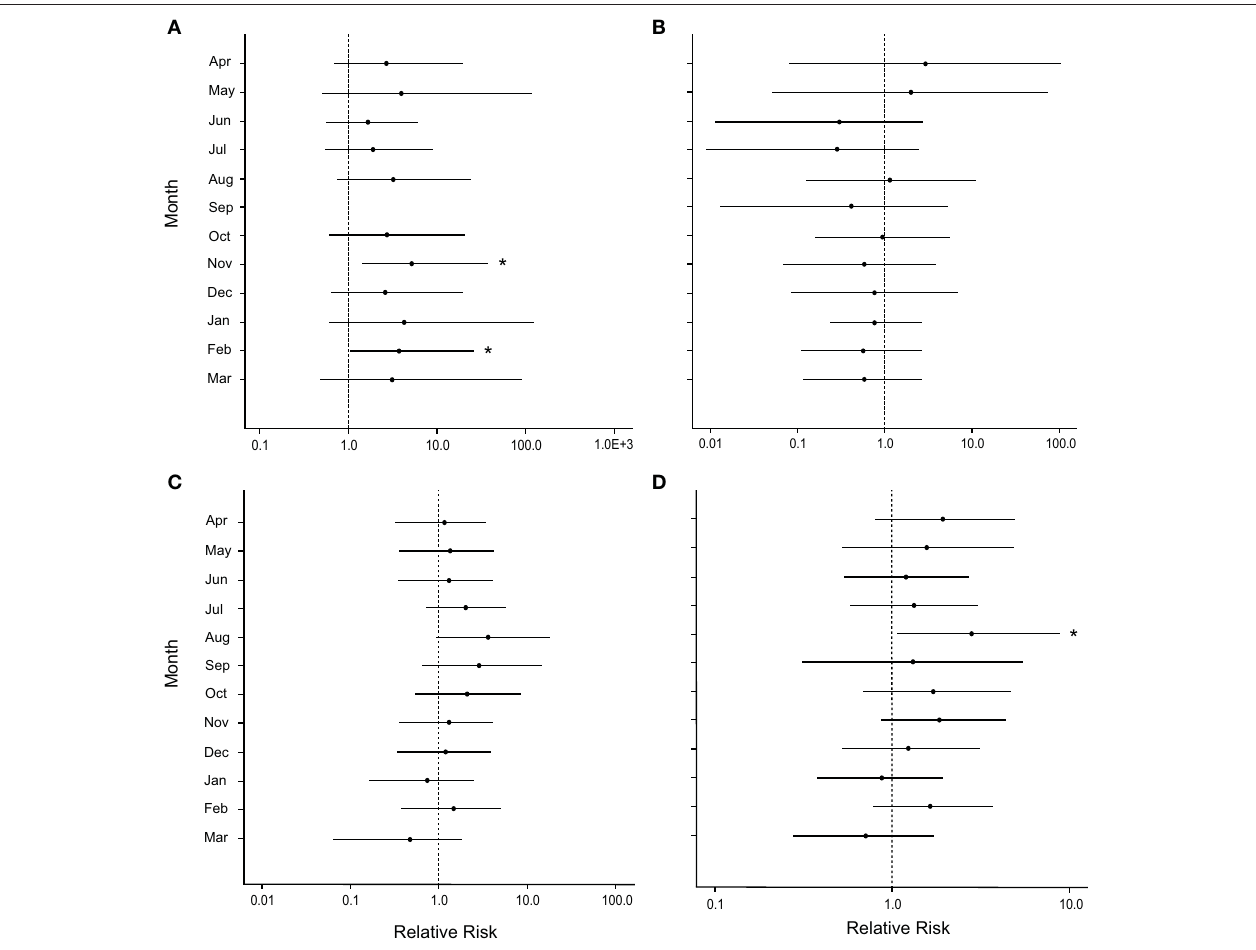
FIGURE 7 | Caterpillar plots depicting the median (black dot) and 95% credible intervals for the relative risk of occupation by the snail, Coralliophila abbreviata , after damage from the March swells at (A) Botany Bay, (B) Hawksnest Bay, (C) Haulover Bay, and (D) all sites combined. Asterisks indicate a statistically significant increase in disease